Question: Give a one-sentence summary of this figure.
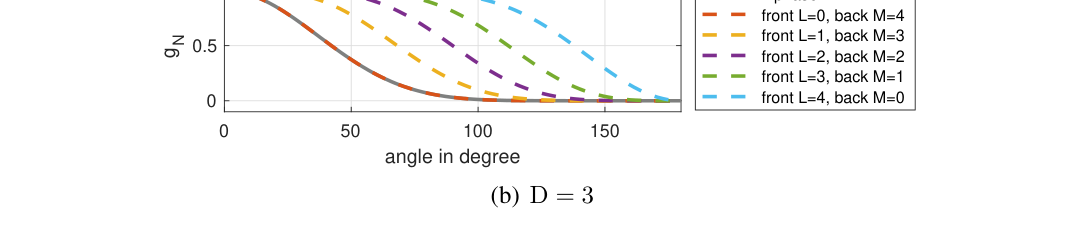
Answer: – Examples for maximally flat designs with L + 1 flatness degrees on axis, and a zero with M + 1 flatness degrees for N = L + M + 1 and for D = 2 and D = 3.